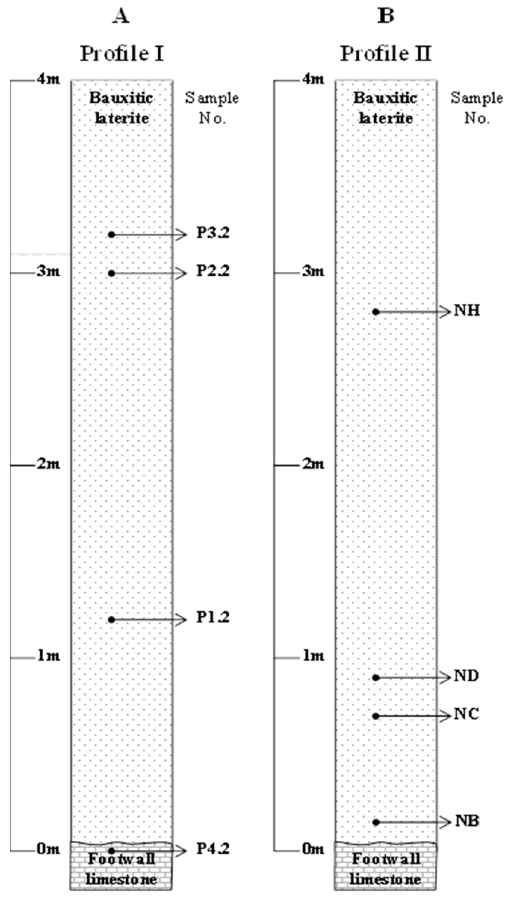
Figure 2. The columnar sections of the studied bauxite laterite profiles at Patitira (Figure 1, red cycle).